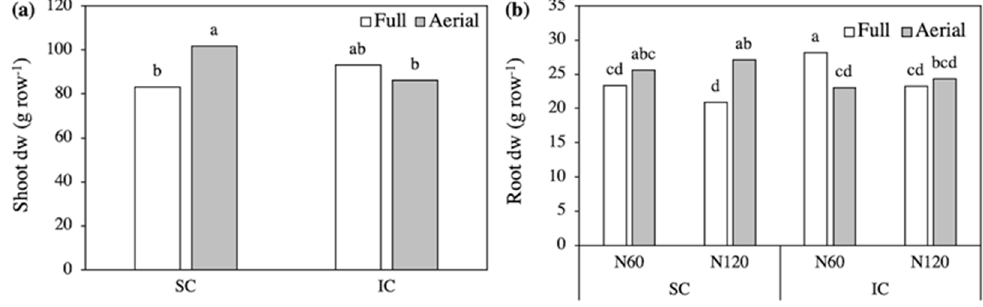
Figure 1. Shoot ( a ) and root ( b ) biomass of field bean, as affected by the Crop system × Row contact interaction (shoot) and by the Crop system × N level × Row contact interaction (root). SC, sole crop; IC, intercrop. Values are means of two N levels and three replicates (shoot) and of three replicates (root). In each figure, bars with different letters indicate that the corresponding means are significantly different at P < 0.05, Tukey’s test.